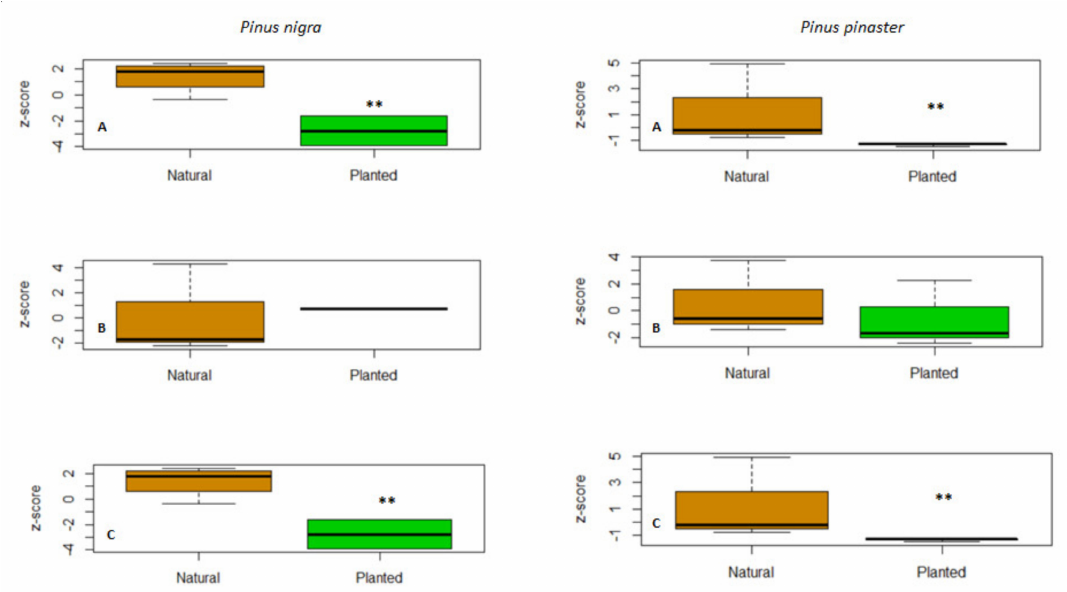
Figure 5. Z-scores of concentrations of δ 2 H in ( A ) phenol, 2-methoxy (guaiacol), ( B ) 2-propanone, (4-hydroxy-3-methoxyphenyl) (guaiacyl acetone) and ( C ) octadecenoic acid (oleic acid) in tree-ring wood of natural (brown box plots) and planted (green box plots) Pinus nigra and P. pinaster stands. Difference levels of significance are shown based on U Mann–Whitney test comparing natural vs. planted stands. Significance levels: * p ≤ 0.05; ** p ≤ 0.01; *** p ≤ 0.001. Significant differences between natural and planted stands are shown with asterisks (** p ≤